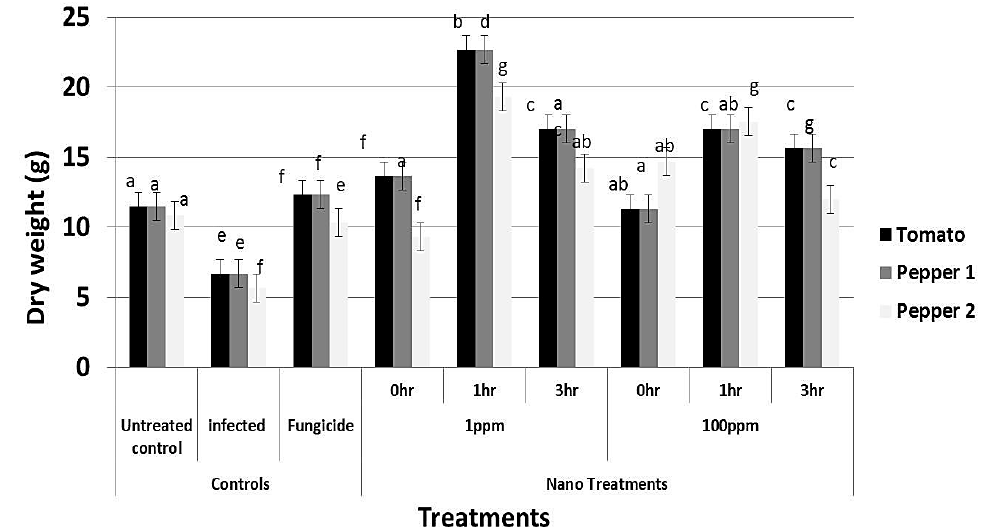
Figure 10. Effect of rGO-CuO NP treatments, as indicated, on plant height of tomato and pepper plants (nine biological replicates). Two independent experiments with pepper plants are plotted. Letters on bars mean statistically significant differences between the mean of the respective control and the nanocomposite at the same concentration ( p ˂ 0.05).